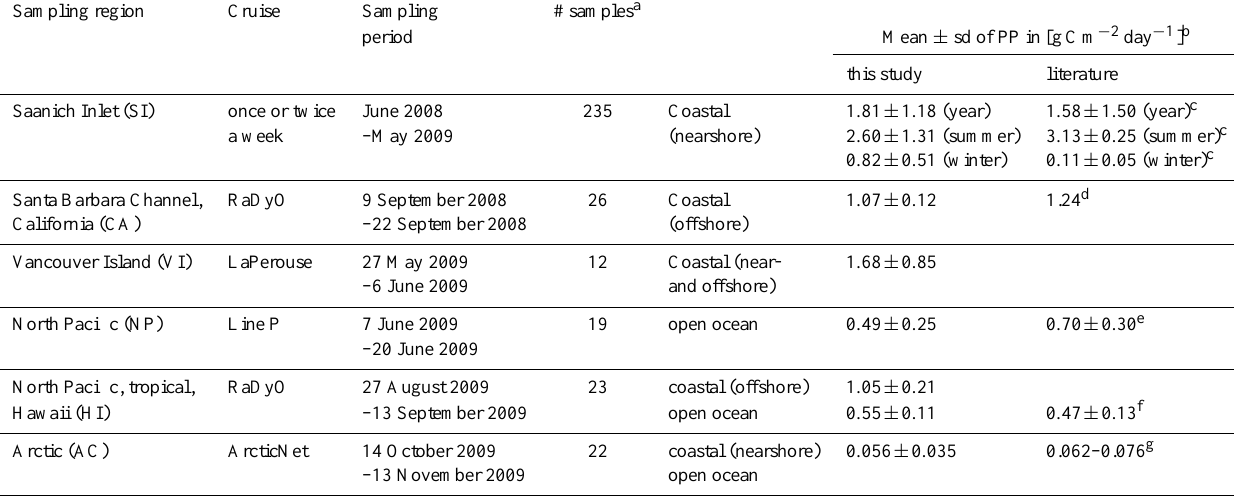
Table 1. Details of sampling events and local primary production (PP).